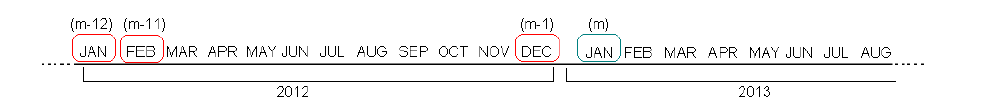
Figure 1. Diagram showing which of the months of forecasts (highlighted in red) will be used for the calculation of the mean bias for the month of January 2013 (highlighted in